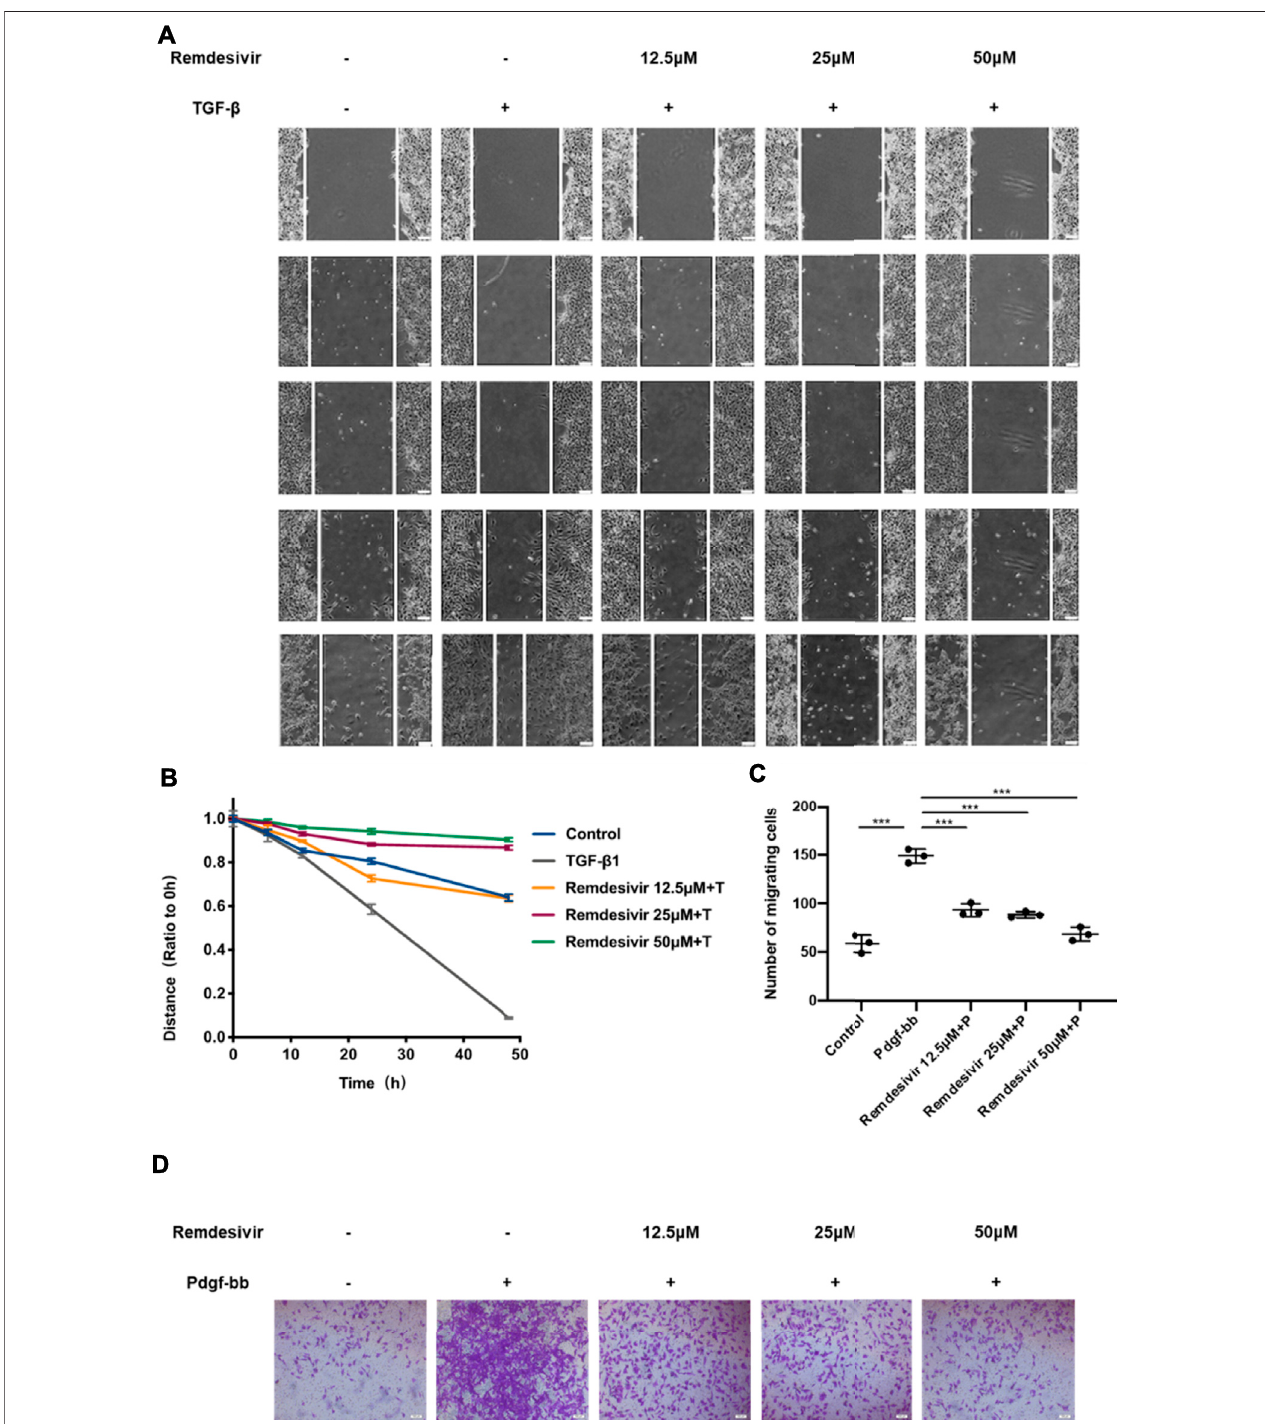
FIGURE 4 | Remdesivir suppresses TGF- β 1-induced migration of lung fi broblasts. (A – B) Wound healing assays of NIH3T3 co-cultured with TGF- β 1 (5 ng ml − 1 ) andRemdesivir(12.5,25,50 μ M).Thewoundclosurewasphotographedat0,6,12,24,and48 hpost-scratching (C – D) NIH-3T3cellstreatedwith/withoutRemdesivir (12.5, 25, 50 μ M) and/or Pdgf-bb (5 ng ml − 1 ). Scale bar (cid:1) 60 μ m. Data was presented as the means ± SD, n (cid:1) 3. * p < 0.05, ** p < 0.01, *** p < 0.001, **** p < 0.0001.